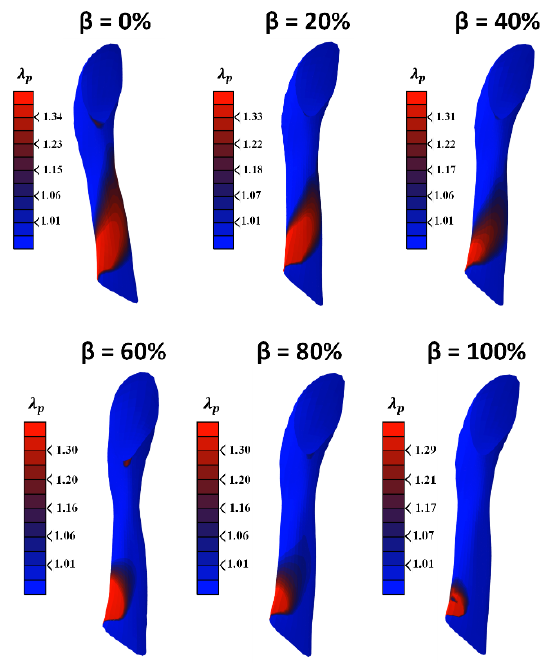
Figure 8. ACL-damage distribution (plastic change) at 3% post-yielding strain.